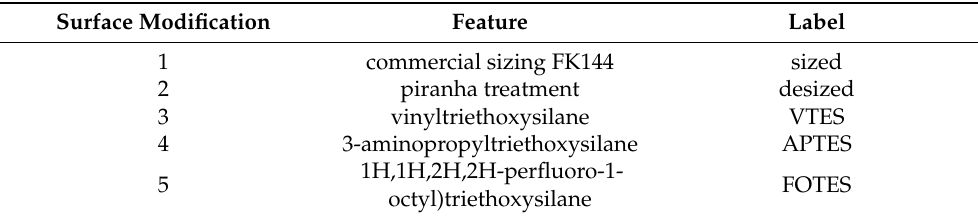
Table 1. Different surface modifications of glass fibers prior to and after desizing, and attached organo-silane treatments with respective